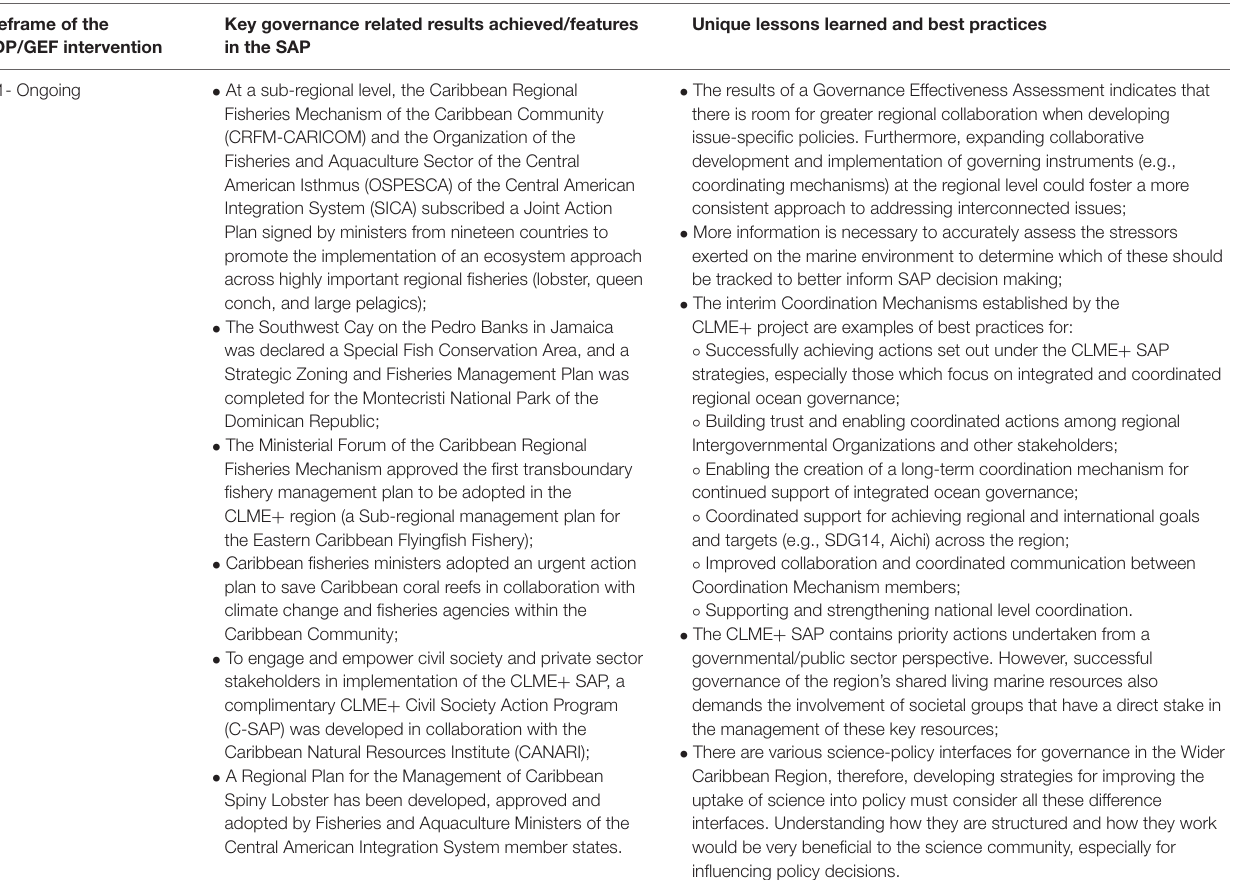
Unique lessons learned and best